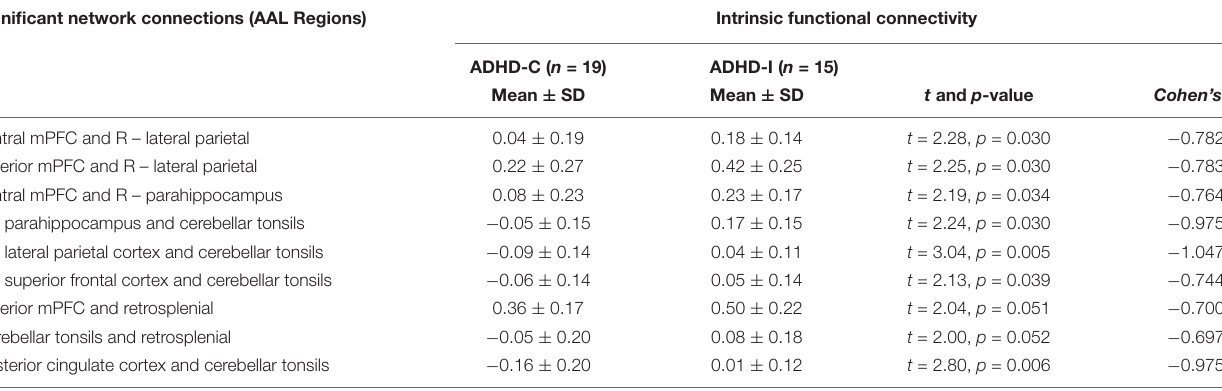
Mean and standard deviations for the connectivity strengths of the significant different connections in the default mode network, ventral mPFC; ventral medial prefrontal cortex, anterior mPFC; anterior medial prefrontal cortex, L, left; R, right. TABLE 4 | Correlations between connectivity for the links of the default mode network identified to be significantly different between the ADHD-C and ADHD-I Groups and the ADHD-RS scores. ADHD combined and predominantly inattentive type participants ( n =